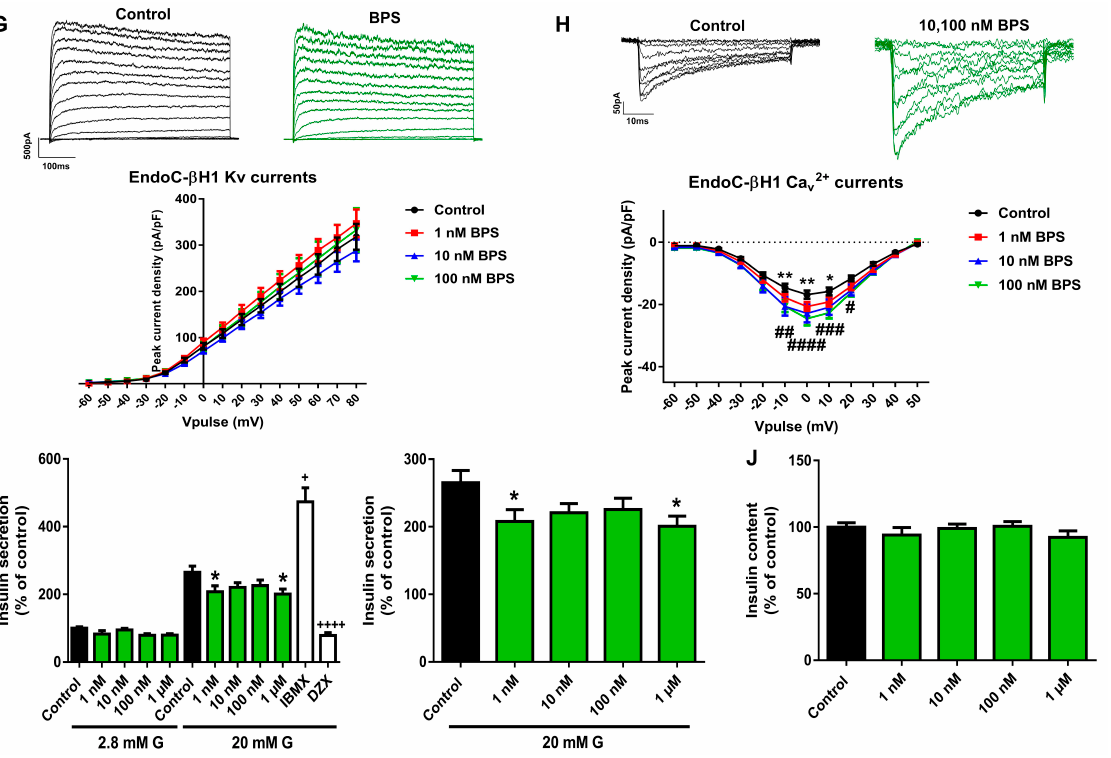
Figure 2. BPS effects on pancreatic β -cells . ( A ) Viability of MIN6 cells treated for 24 h with different BPS concentrations (100 pM–10 µ M) as evaluated by RZ, NRU and CFDA-AM assays. n =